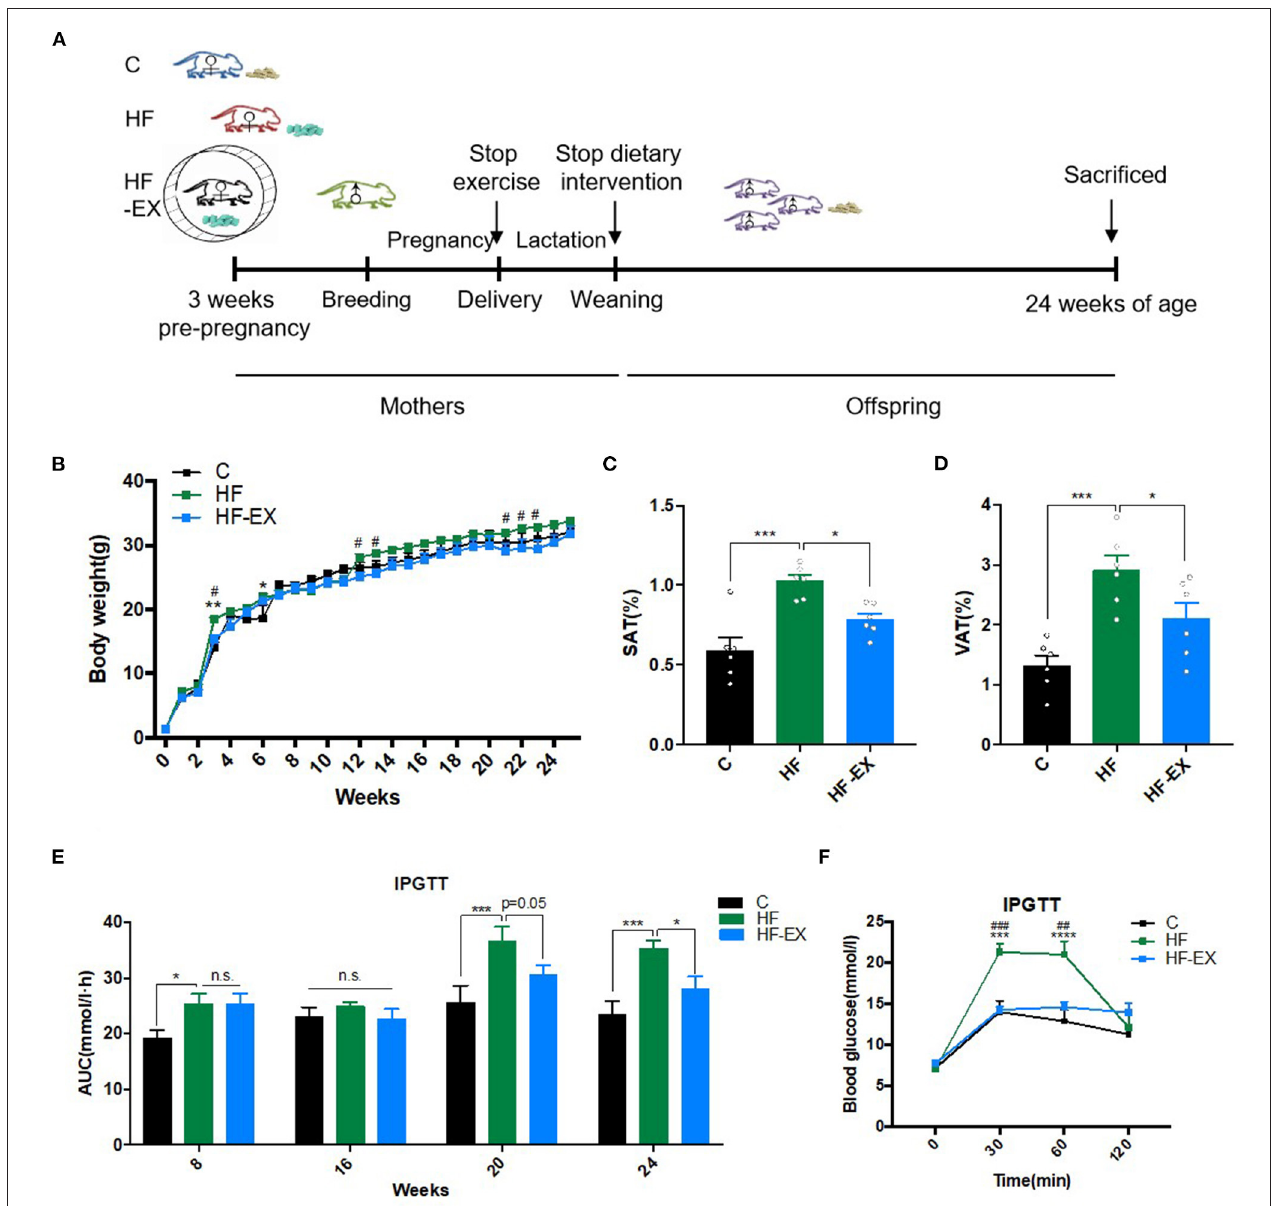
FIGURE 1 | Glucose and lipid metabolism in male offspring. (A) Experimental scheme; (B) body weight changes; (C) subcutaneous adipose tissue mass at 24 weeks; (D) visceral adipose tissue content at 24 weeks; (E) AUC of blood glucose values during intraperitoneal glucose tolerance tests; (F) intraperitoneal glucose tolerance test at 24 weeks. C, offspring of dams fed the normal control diet; HF, offspring of dams fed the high-fat diet; HF-EX, offspring of dams intervened with a high-fat diet and exercise; SAT, subcutaneous adipose tissue mass; VAT, visceral adipose tissue; IPGTT, intraperitoneal glucose tolerance test; AUC, area under the curve. Data are expressed as means ± SD ( n = 6/group) and are analyzed by one-way ANOVA or two-way ANOVA, with Turkey post-hoc analyses. Mean values were significantly different between the groups: *HF vs. C, * p < 0.05, ** p < 0.01, *** p < 0.001, **** p < 0.0001; # HF-EX vs. HF, # p < 0.05, ## p < 0.01, ### p < 0.001.